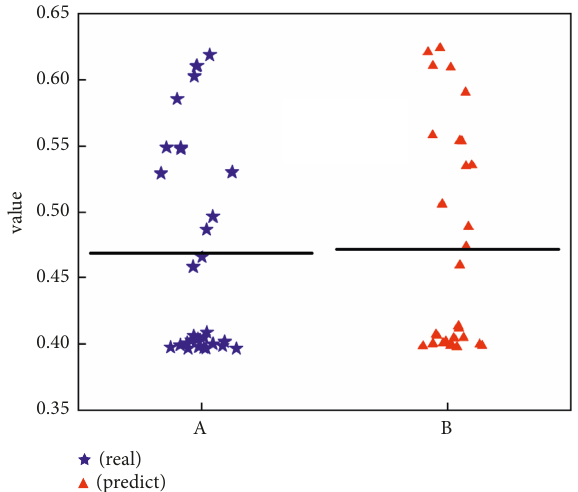
Figure 8: Numerical distribution of predicted cabinets for musical innovation effect characteristics.